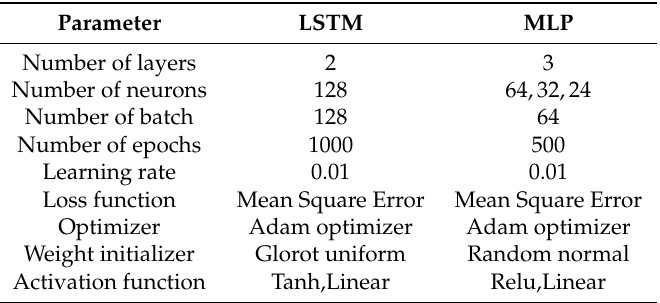
Table 5. Parameter of LSTM and MLP.